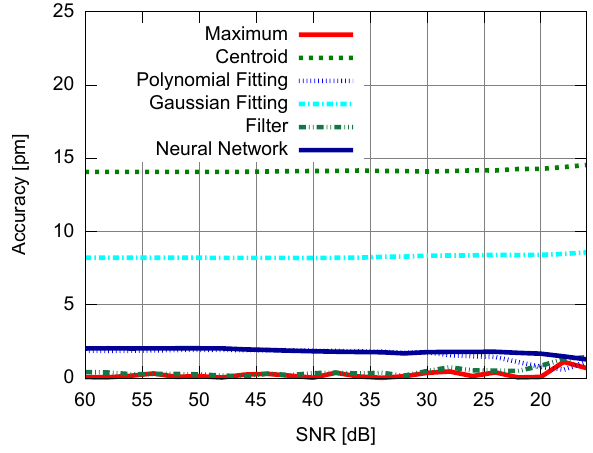
Figure 11. Accuracy for the gaussian modulation profile.